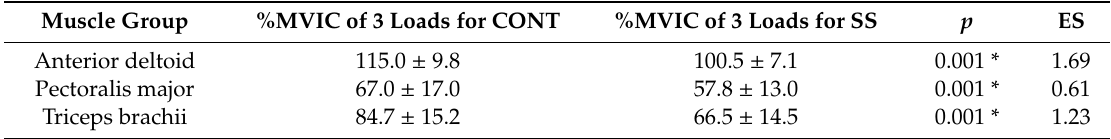
Table 3. Post hoc analysis for the main interaction of two conditions vs. three muscle groups.